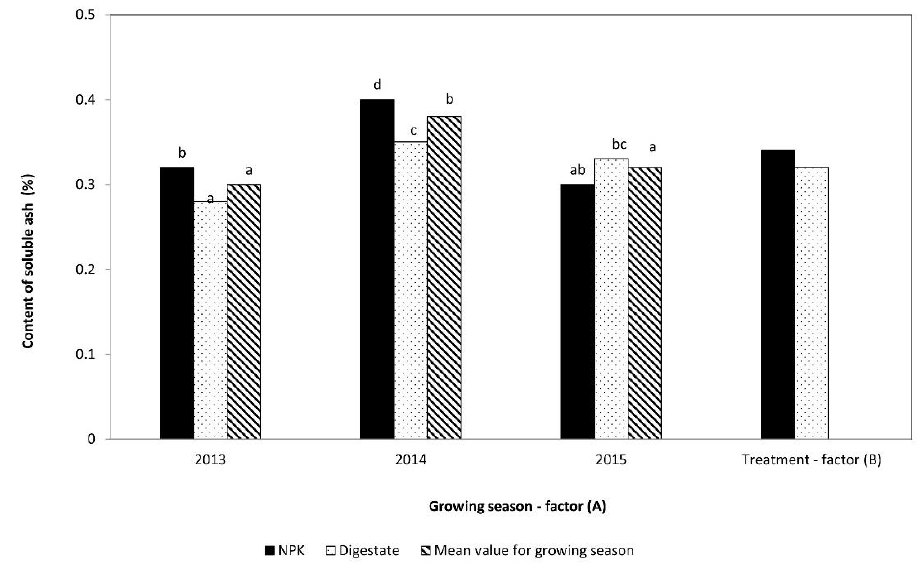
beet Figure 7. Effects of growing seasons and fertilization treatments on content of soluble ash in sugar beet roots.